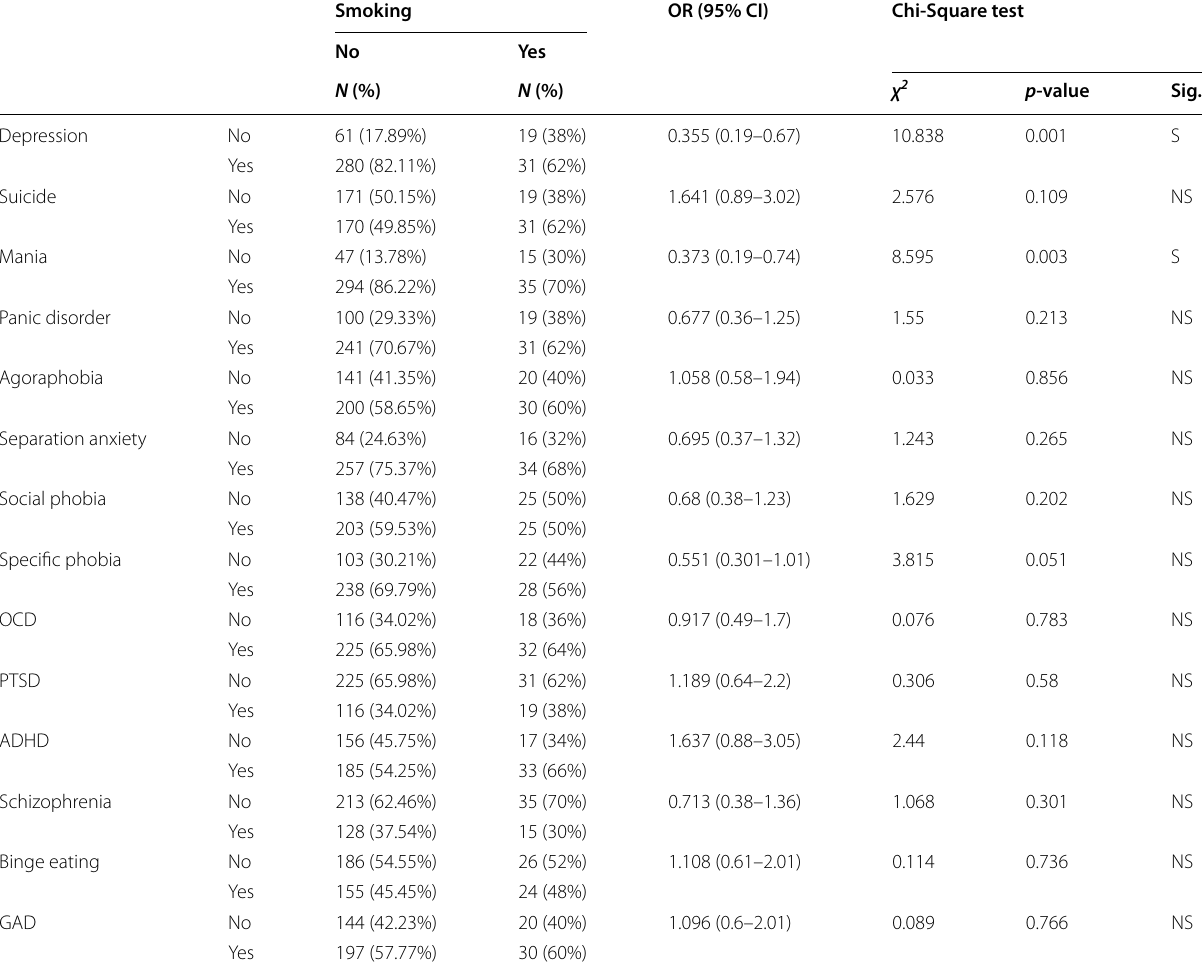
Table 4 Psychiatric symptoms in adolescent smokers according to MINI-KID Smoking OR (95%